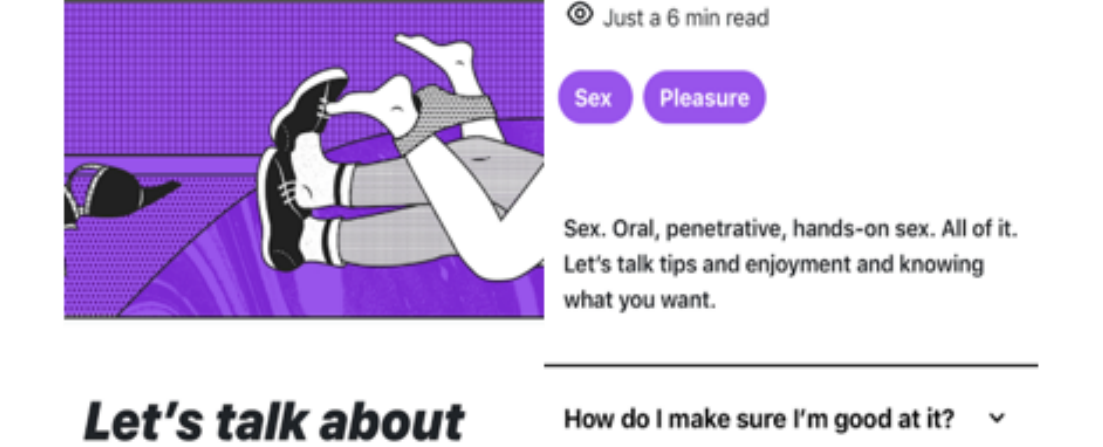
Figure 7. The Gist article structure utilizing progressive disclosure to increase user